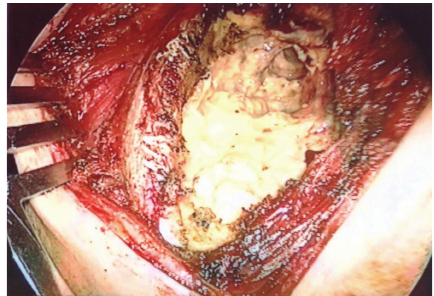
Figure 3: Operative findings in Case 2. Emergency cavernostomy was done for repeated uncontrollable infections. Aspergillus fumiga- tus was detected from the cavity.